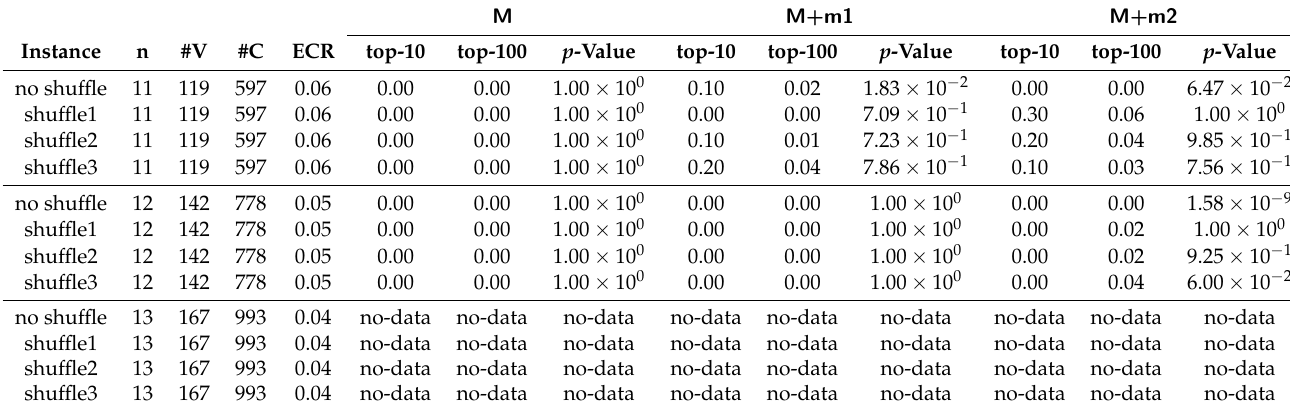
Table 6. DRUP analysis results of PHP instances with partial extension for